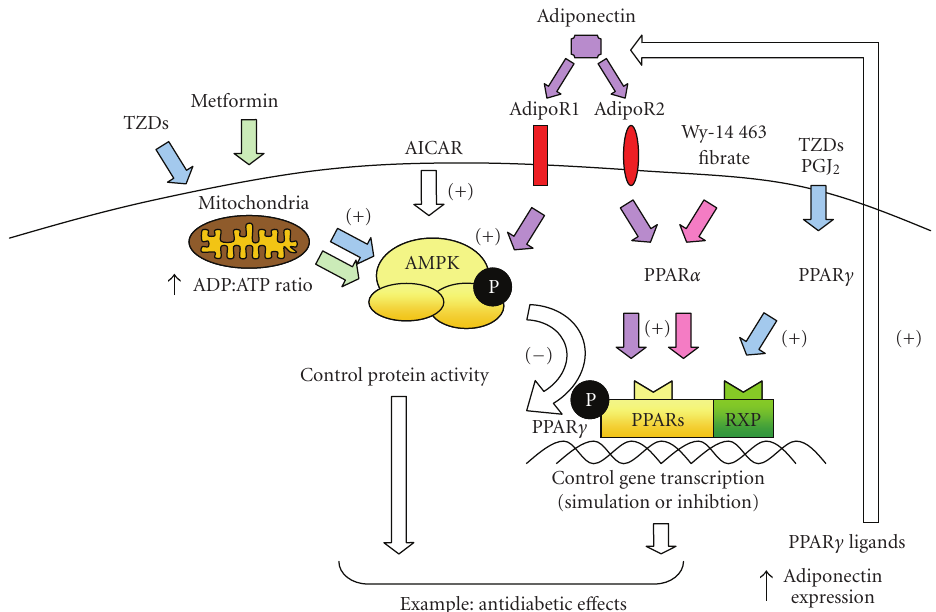
Figure 1: Schema illustrating the putative functional interactions between PPARs, AMPK, and adiponectin. PPAR γ is activated by binding with PGJ 2 or TZDs and PPAR α with fibrates or WY 14 463. They control gene transcription, and, in particular, PPAR γ ligands increase adiponectin expression [49]. Metformin and TZDs activate AMPK probably via the respiratory chain in mitochondria [22], and AICAR stimulates AMPK. AMPK controls protein activity by phosphorylation (e.g., inhibits PPAR γ by phosphorylation [35]). Adiponectin activates AdipoR1 and AdipoR2 receptors which act on metabolism via AMPK (AdipoR1) or PPAR α (AdipoR2) [43].